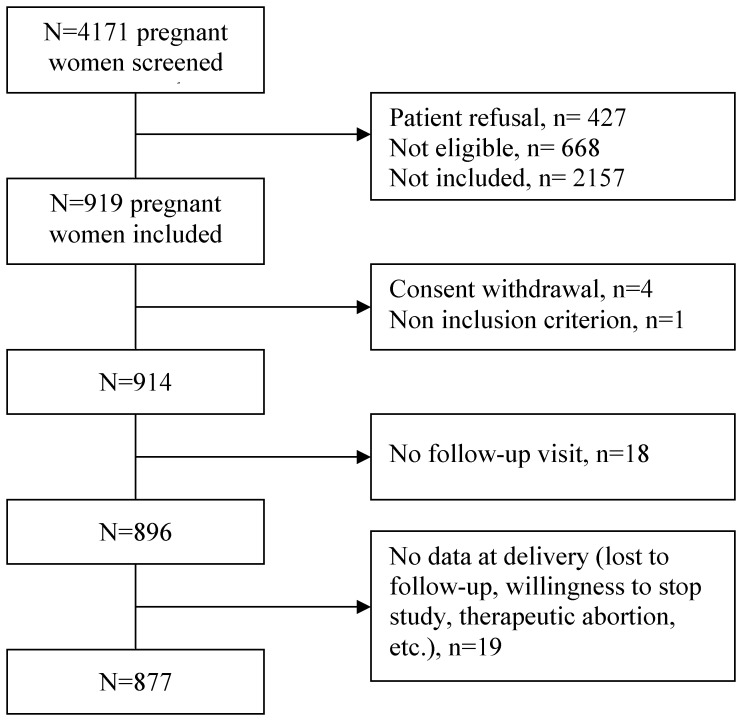
Disposition of pregnant women in the COFLUPREG cohort.